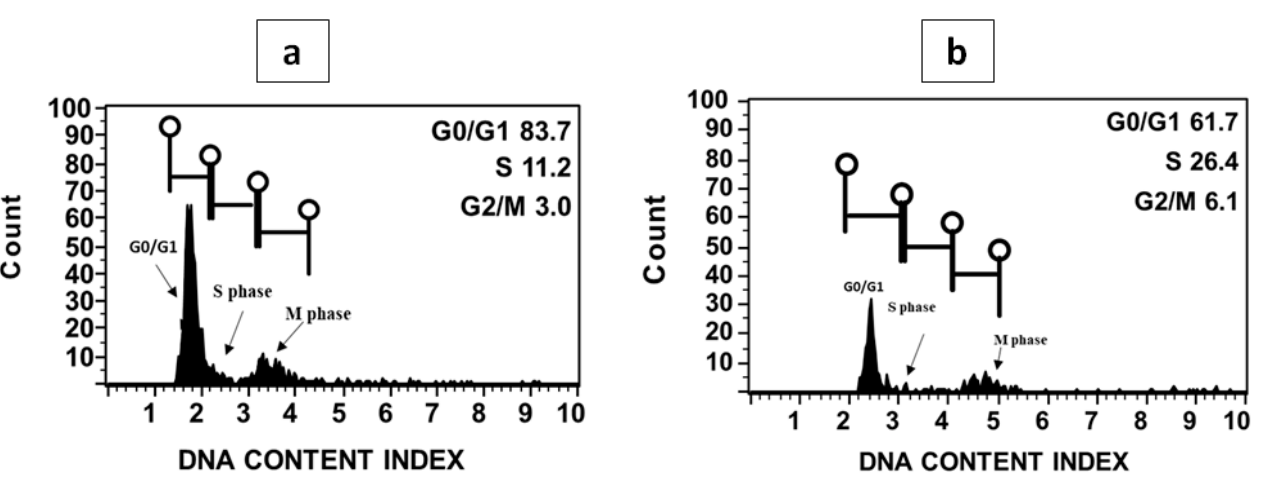
Figure 3. Histogram of fluorescence intensity for genome size assessments in R. lutea ( a ) and R. pentagyna ( b ) nuclei stained with propidium iodide prepared from shoot tissues. The two major phases of the cell cycle (interphase G0, G1, S, G2 and the mitotic phase M). Table 1. C-value comparison (flowcytometry vs. k-mer) genome size and G0/G1 phases of the cell cycle in Reseda lutea and Reseda pentagyna . Genome size (mean ± standard deviation). The number of individuals analyzed for genome size ( n ).